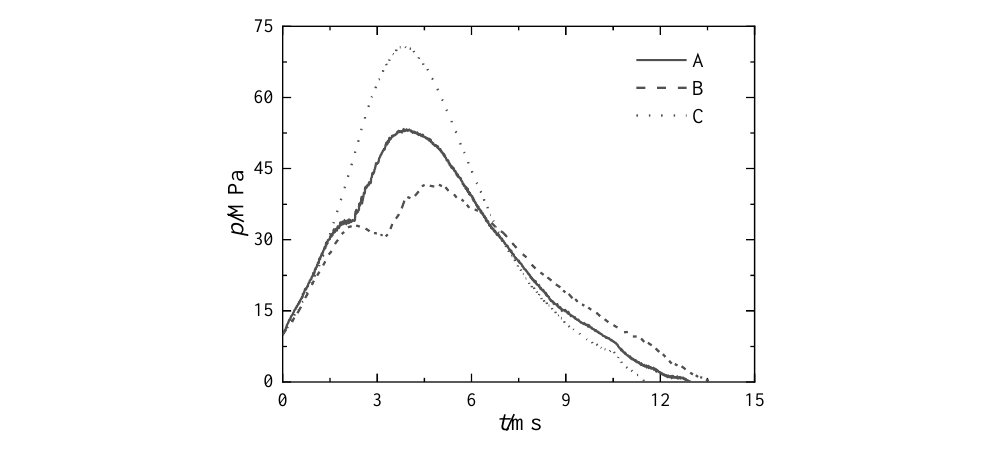
Figure 3. Chamber pressure curve under three launching conditions. Table 2. Interior ballistics results.